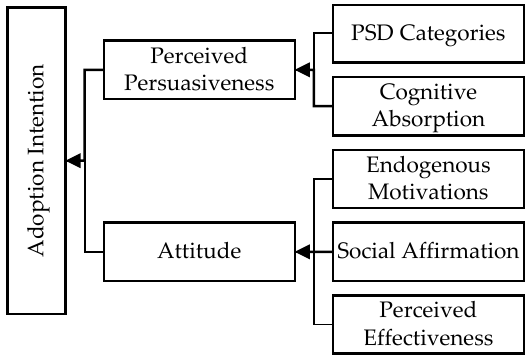
Figure 2. Dependence of constructs in Studies I–III.